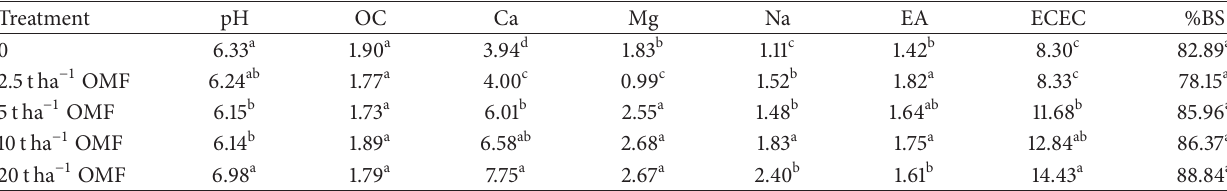
Table 4: Effect of organomineral fertilizer on soil chemical properties.